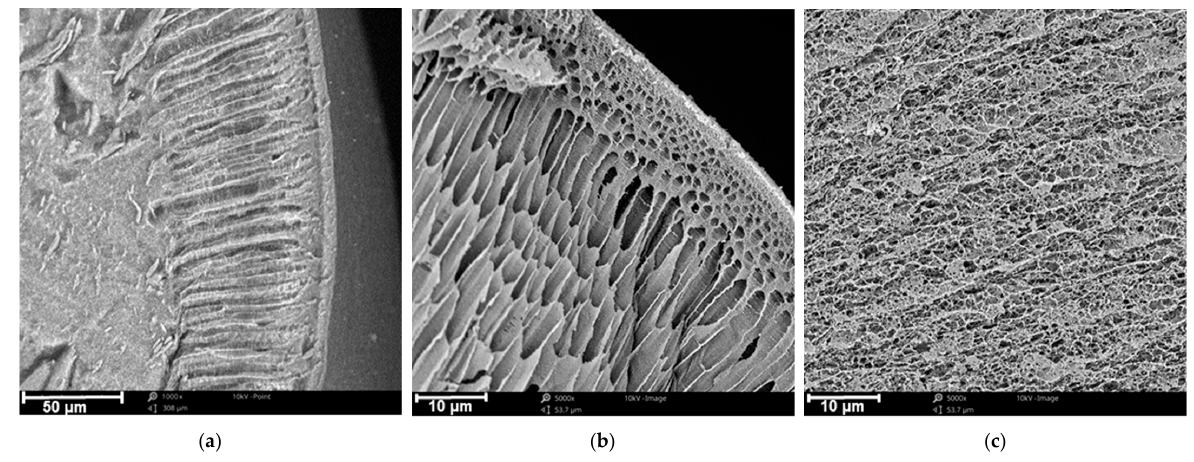
Figure 3. SEM image of a cross-section of the Mn-biosorbent bead: near-surface layer, mag. 1000× ( a ); near-surface layer, mag. 5000× ( b ); and middle area of the bead, mag. 5000× ( c ). Table 1. The element content in the unmodified chitosan and Mn-biosorbent bead determined by the EDS analysis.